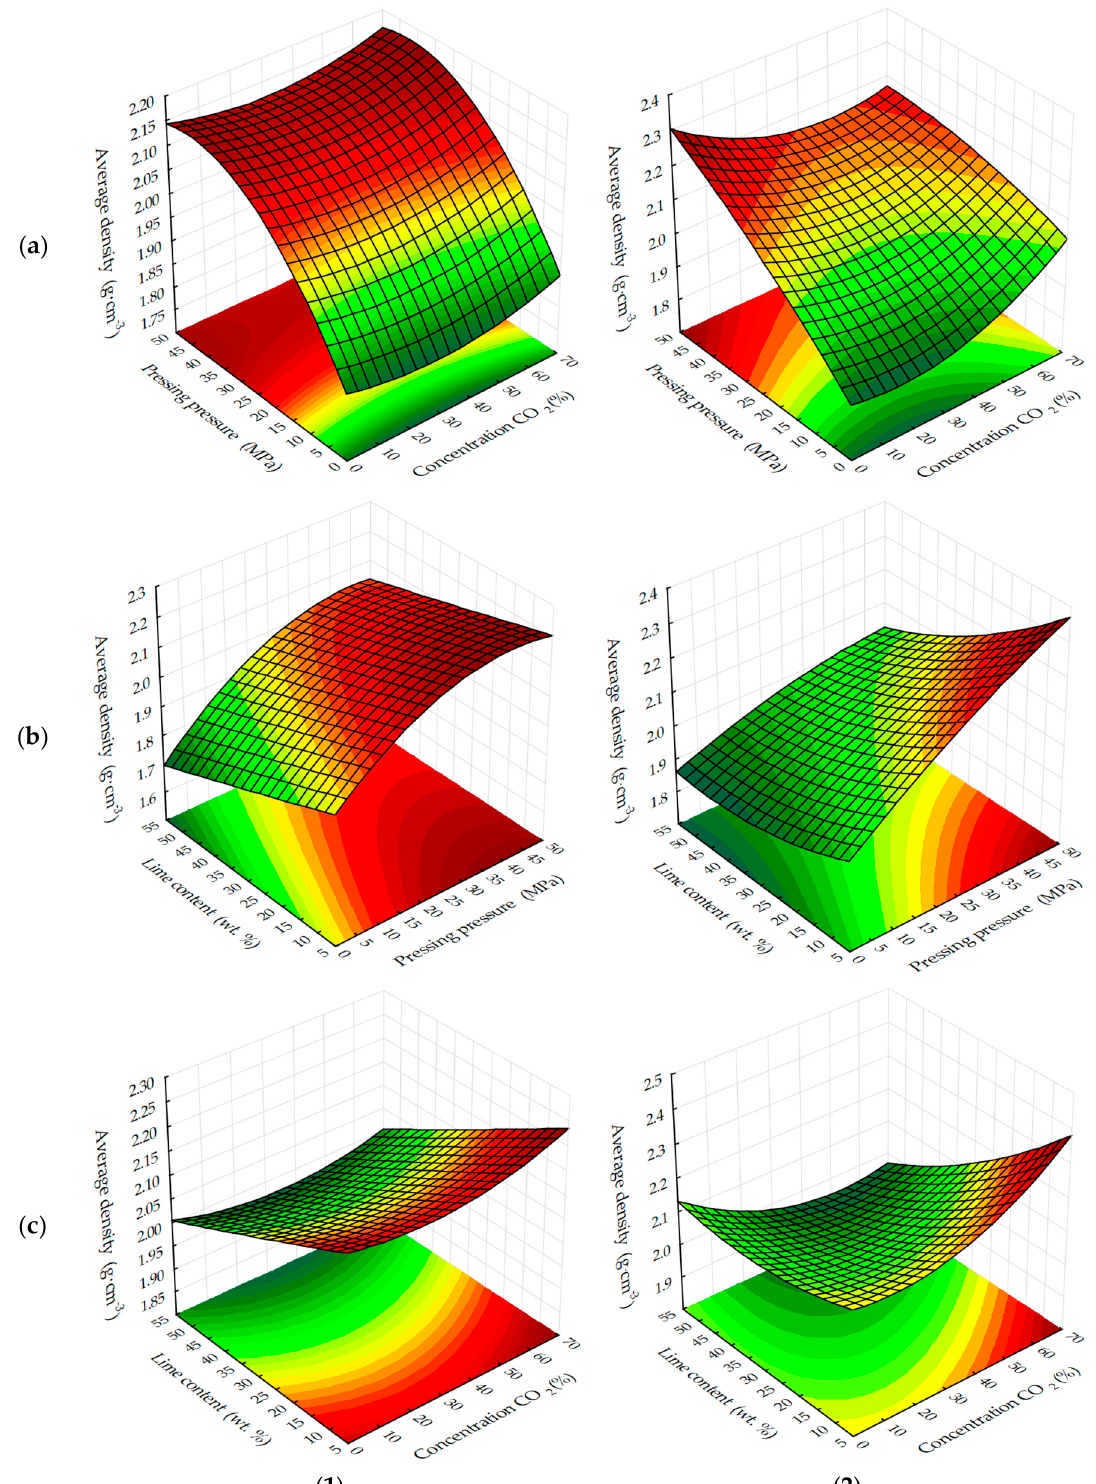
Figure 5. Response surfaces of changes in the average density of testing samples carbonated by dynamic ( 1 ) and static ( 2 ) methods, depending on: ( a ) the forming pressure of pressing and concentration of CO 2 ; ( b ) the content of lime dust and forming pressure pressing; ( c ) the content of lime dust and concentration of CO 2 (at zero level of variation of other factors).